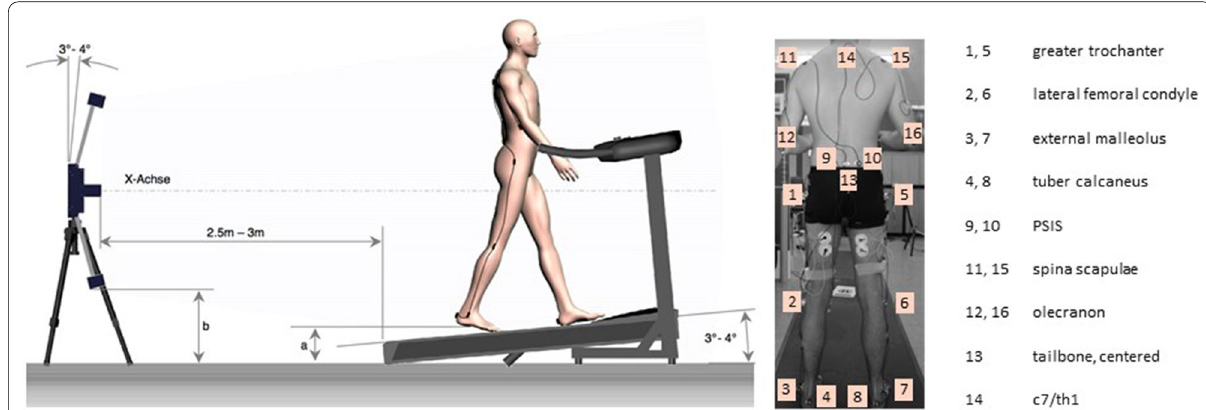
Fig. 1 Schematic figure showing the layout of the gait analysis with the LUKOtronic Motion-Capture-Unit MCU200 (left); Picture with all the infrared marker positions shown from behind